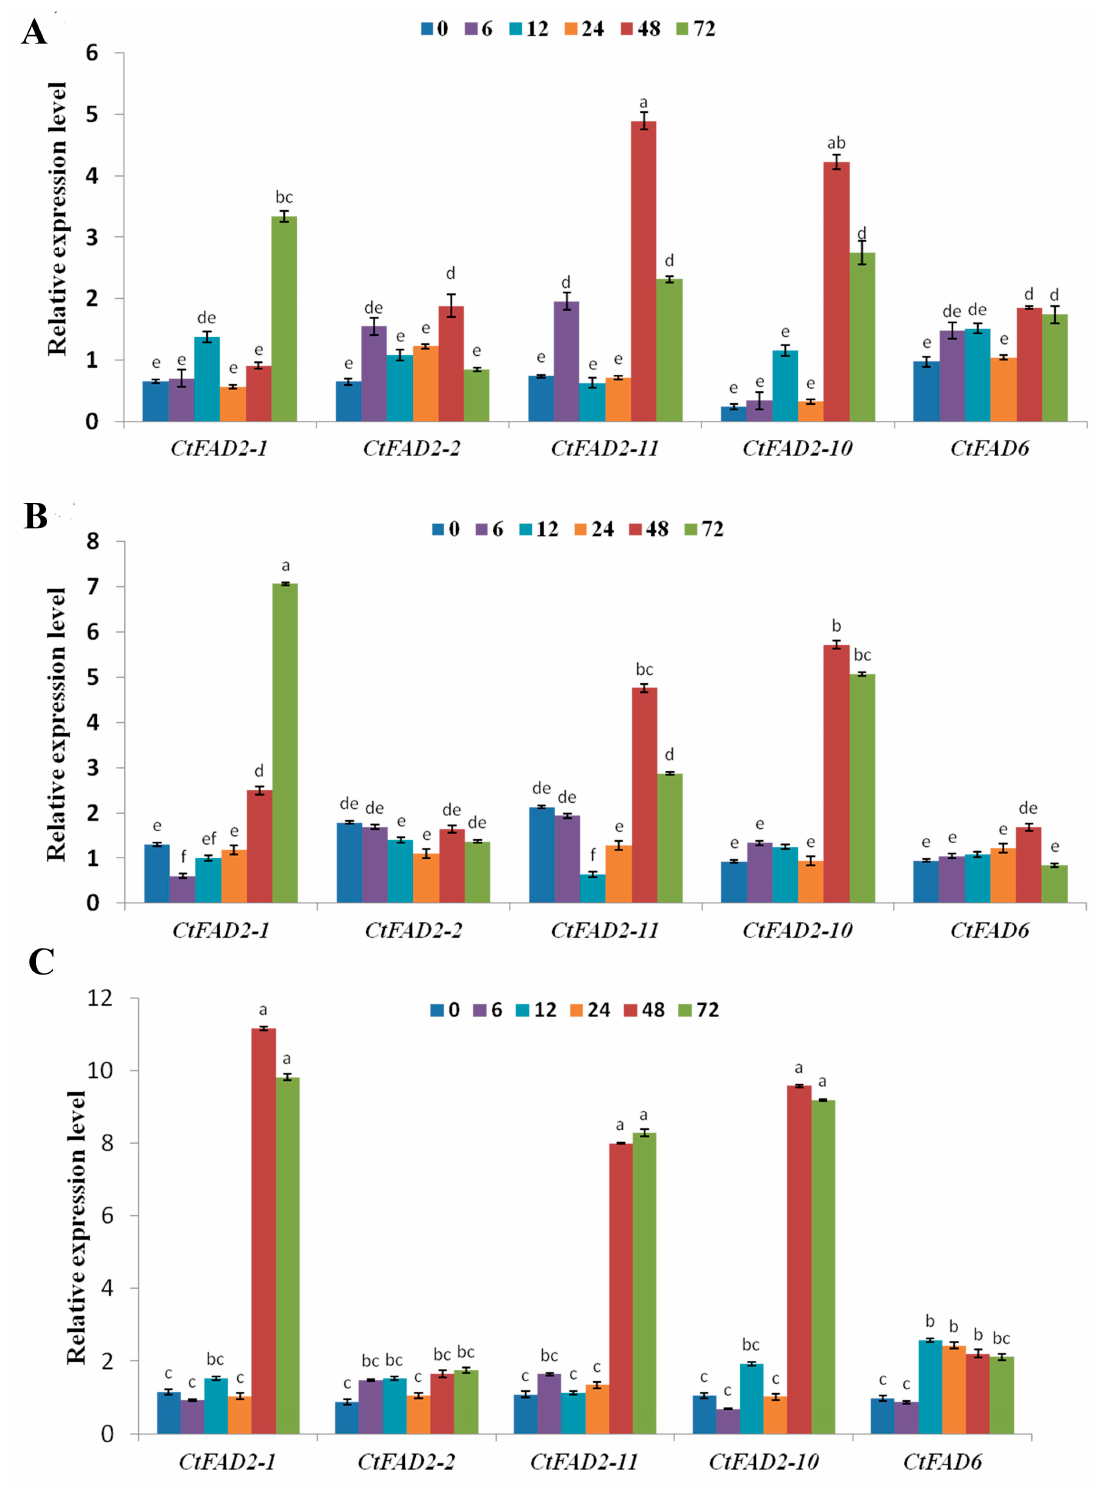
Figure 3. Effect of salt on the relative expression levels of safflower CtFAD2-1 , CtFAD2-2 , CtFAD2-10 , CtFAD2-11 and CtFAD6 genes in root, stem and leaf tissues; the expressions were detected at 0, 6, 12, 24, 48 and 72 h after salt stress treatment. Note: The letter “( A )” represents the roots, the letter “( B )” represents the stems and the letter “( C )” represents the leaves. Transcription levels for the three tissues were normalized against the samples treated without salt stress, respectively. Each bar represents the mean. Error bars represent the standard deviation of the mean ( n = 3). The different alphabets above each bar indicate significant differences ( p < 0.05).